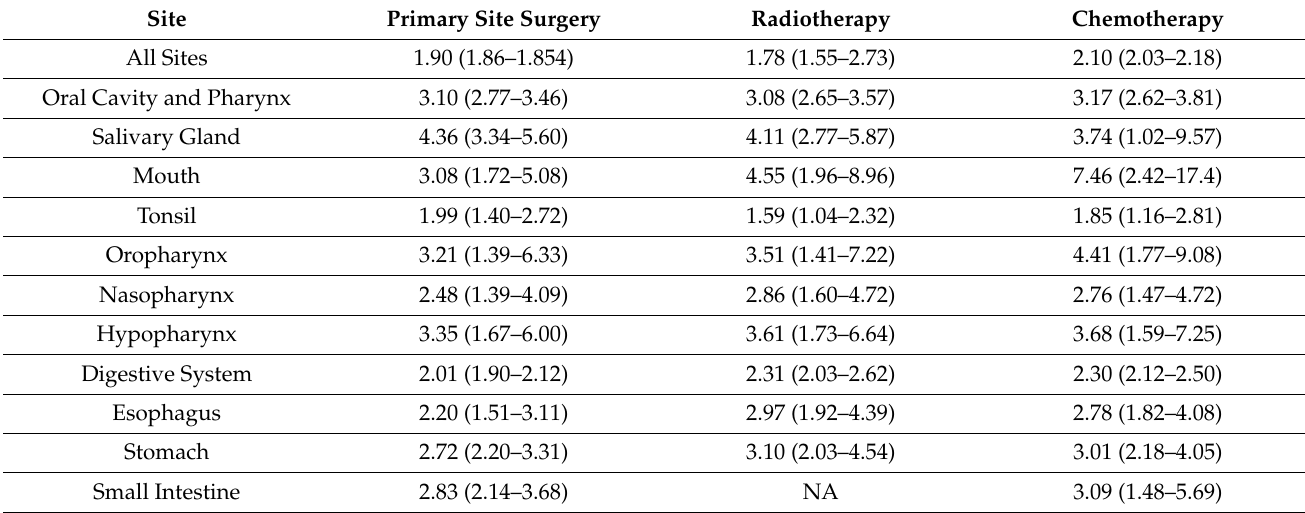
Figure 6. Geographical distribution of elevated risk developing second primary thyroid cancer (SPTC) in the United States. SIR: standardized incidence ratio (observed/expected). ( A ) Mapping counties with significant elevated SIR (n = 155 counties) during the first year following another primary malignancy. Color shows SIR for county, state, and zip code. ( B ) SIR across SEER registries during the first year and lifelong period. Table 3. The risk of SPTC stratified by treatment modalities for primary